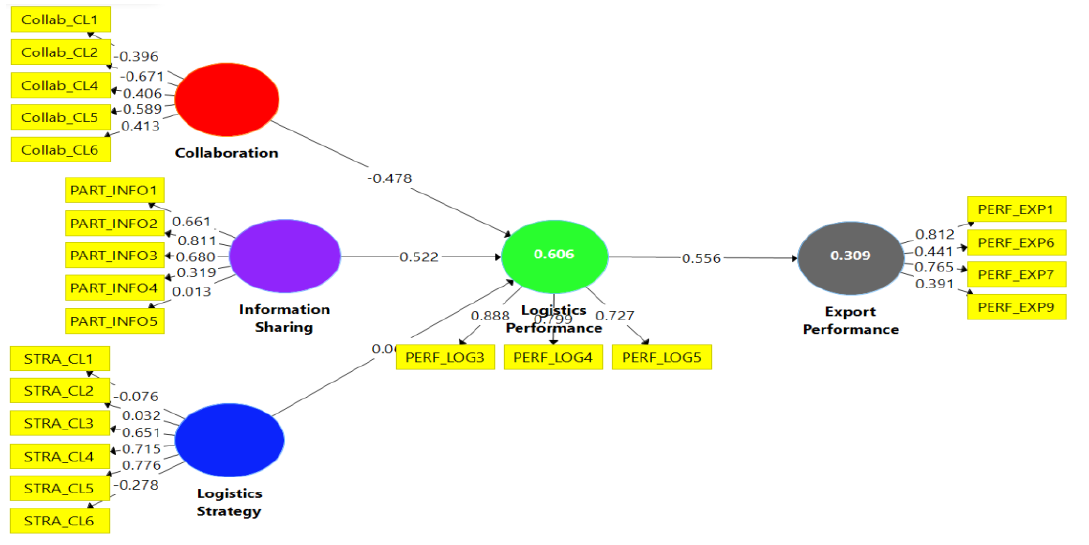
Figure 2 : The adjusted structural model (using Smart PLS Software); Source : Authors